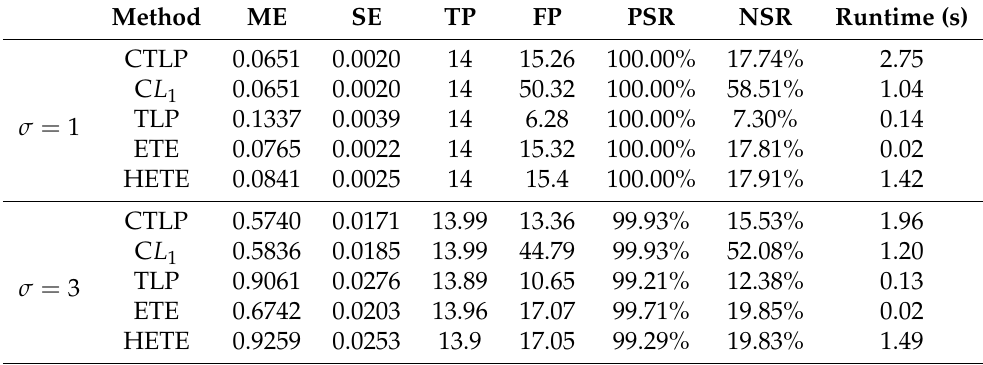
Table 4. The comparison of five methods in the case of n > p , AR ( 1 ) correlation matrix with group